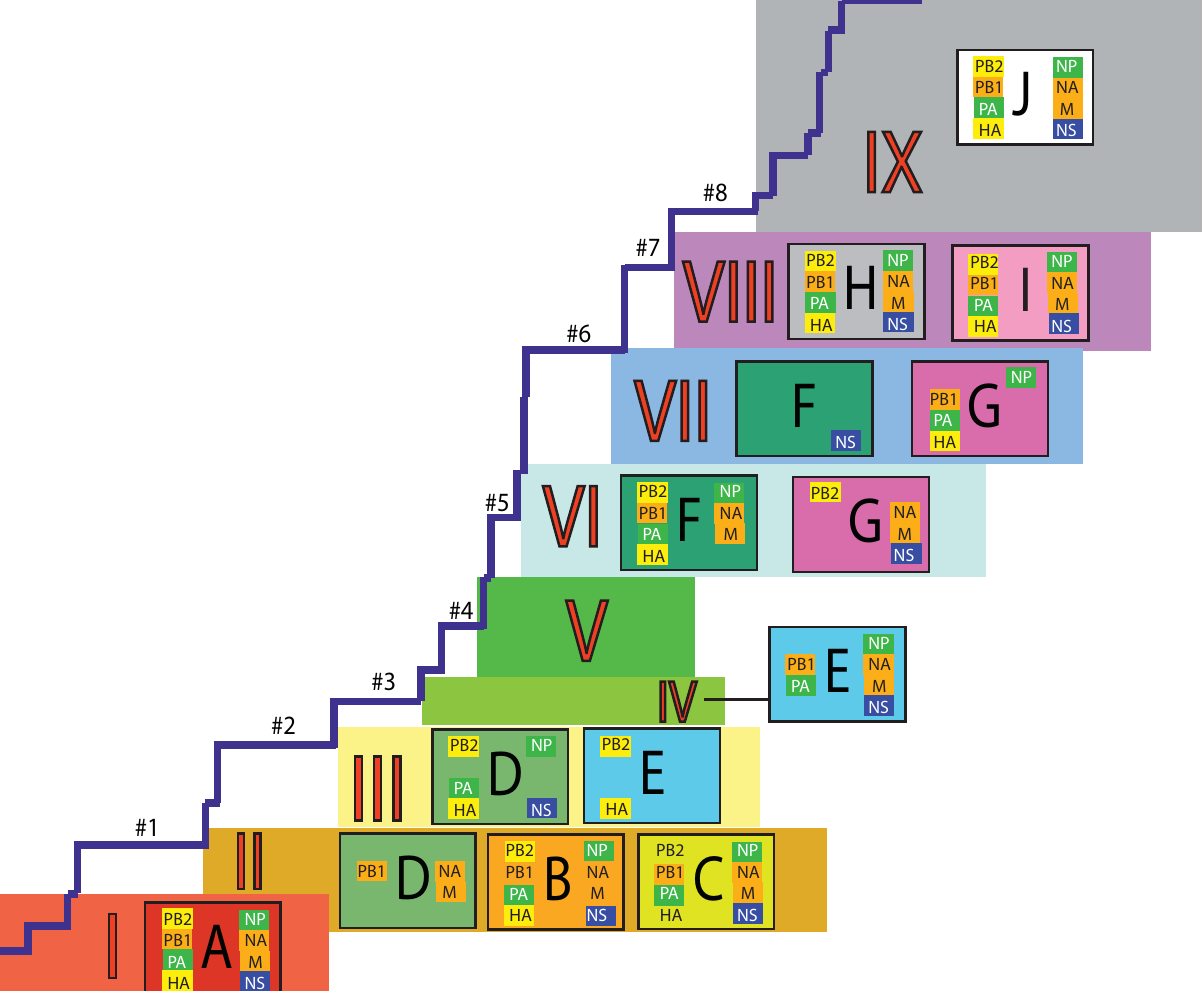
Figure 9. Schematic representation of the phylogenetic patterns of all eight A/H1N1 influenza virus genomes used in this study (Figures 1–8). The main trunk (back-bone) lineage is taken from the HA phylogeny, with the nine sections I–IX and long trunk braches # 1–8 corresponding to their respective positions on HA phylogeny and similarly color-coded. Clades A–J are also color-coded as in Figures 1–8. Each clade is positioned within a given phylogenetic section for all viral genome segments contained within the box. Viral genome segments are color-coded to show similarities in the phylogenetic patterns between multiple segments: PB2 and HA follow similar phylogenetic patterns and are colored in yellow boxes; PB1, NA, and M are phylogenetically similar and are shaded in orange boxes; PA and NP are in green boxes; NS follows a pattern unique to itself and is alone colored in a dark purple box.